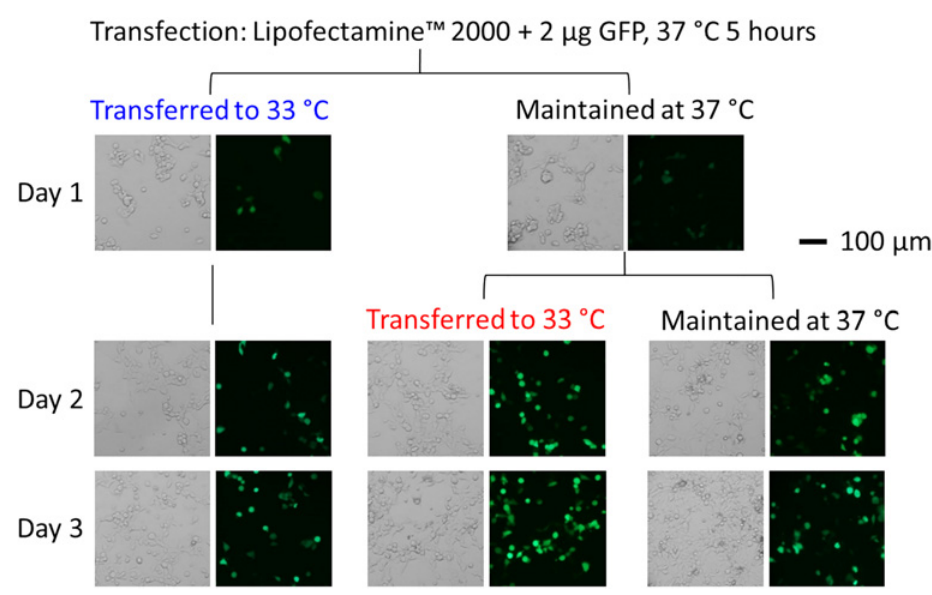
Fig 2. Bright-field and fluorescence images (34.8x magnification) of GFP-expressing HEK-293S cells. The cells were transfected with the GFP plasmid using Lipofectamine 2000. Five hours after transfection (the cells were maintained in a 37°C incubator during this 5-hour period), the medium was replaced. Three sets of dishes were subject to three different ways of maintaining culture temperature, as shown. One set of dishes